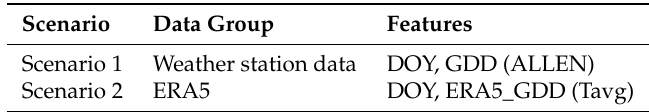
Table 1. Description of the two different scenarios in which to select a ML model for phenology phase